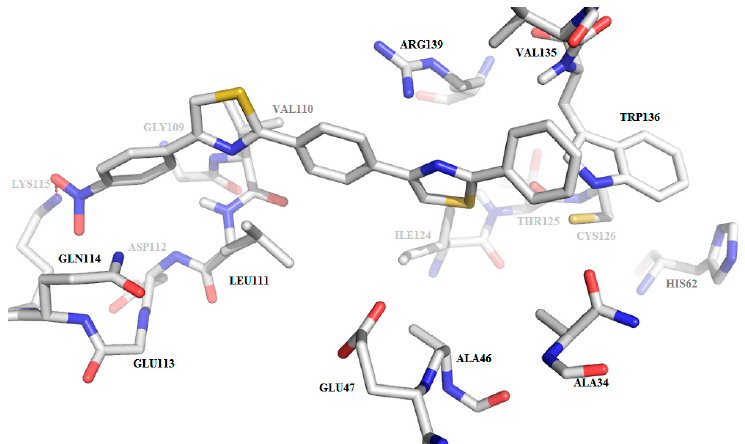
Figure 9. Compound C3 ’s predicted binding mode to the active site of S. aureus Sortase A (PDB 1IJA). Active site and the ligands are depicted as sticks. No hydrogen bonds are predicted; one polar contact (red dashes) between Lys 115 and the nitro group is anticipated. Table 6. Comparative description of the characteristic parameters of the 2 sortases A active sites. Parameter E.